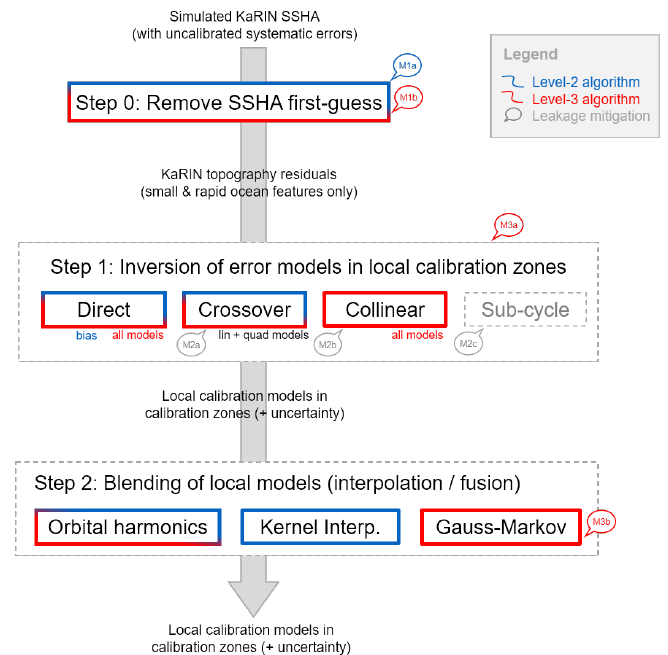
Figure 8. Schematics of the end-to-end calibration scheme. Each rectangle is a processing step. The blue items are for the Level-2 algorithm sequence, and the red items are for the Level-3 algorithm sequence. algorithm